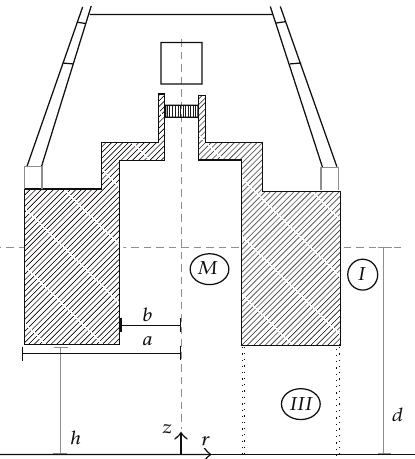
Figure 1: Typical floating oscillating water column device with finite wall thickness. Ring elements